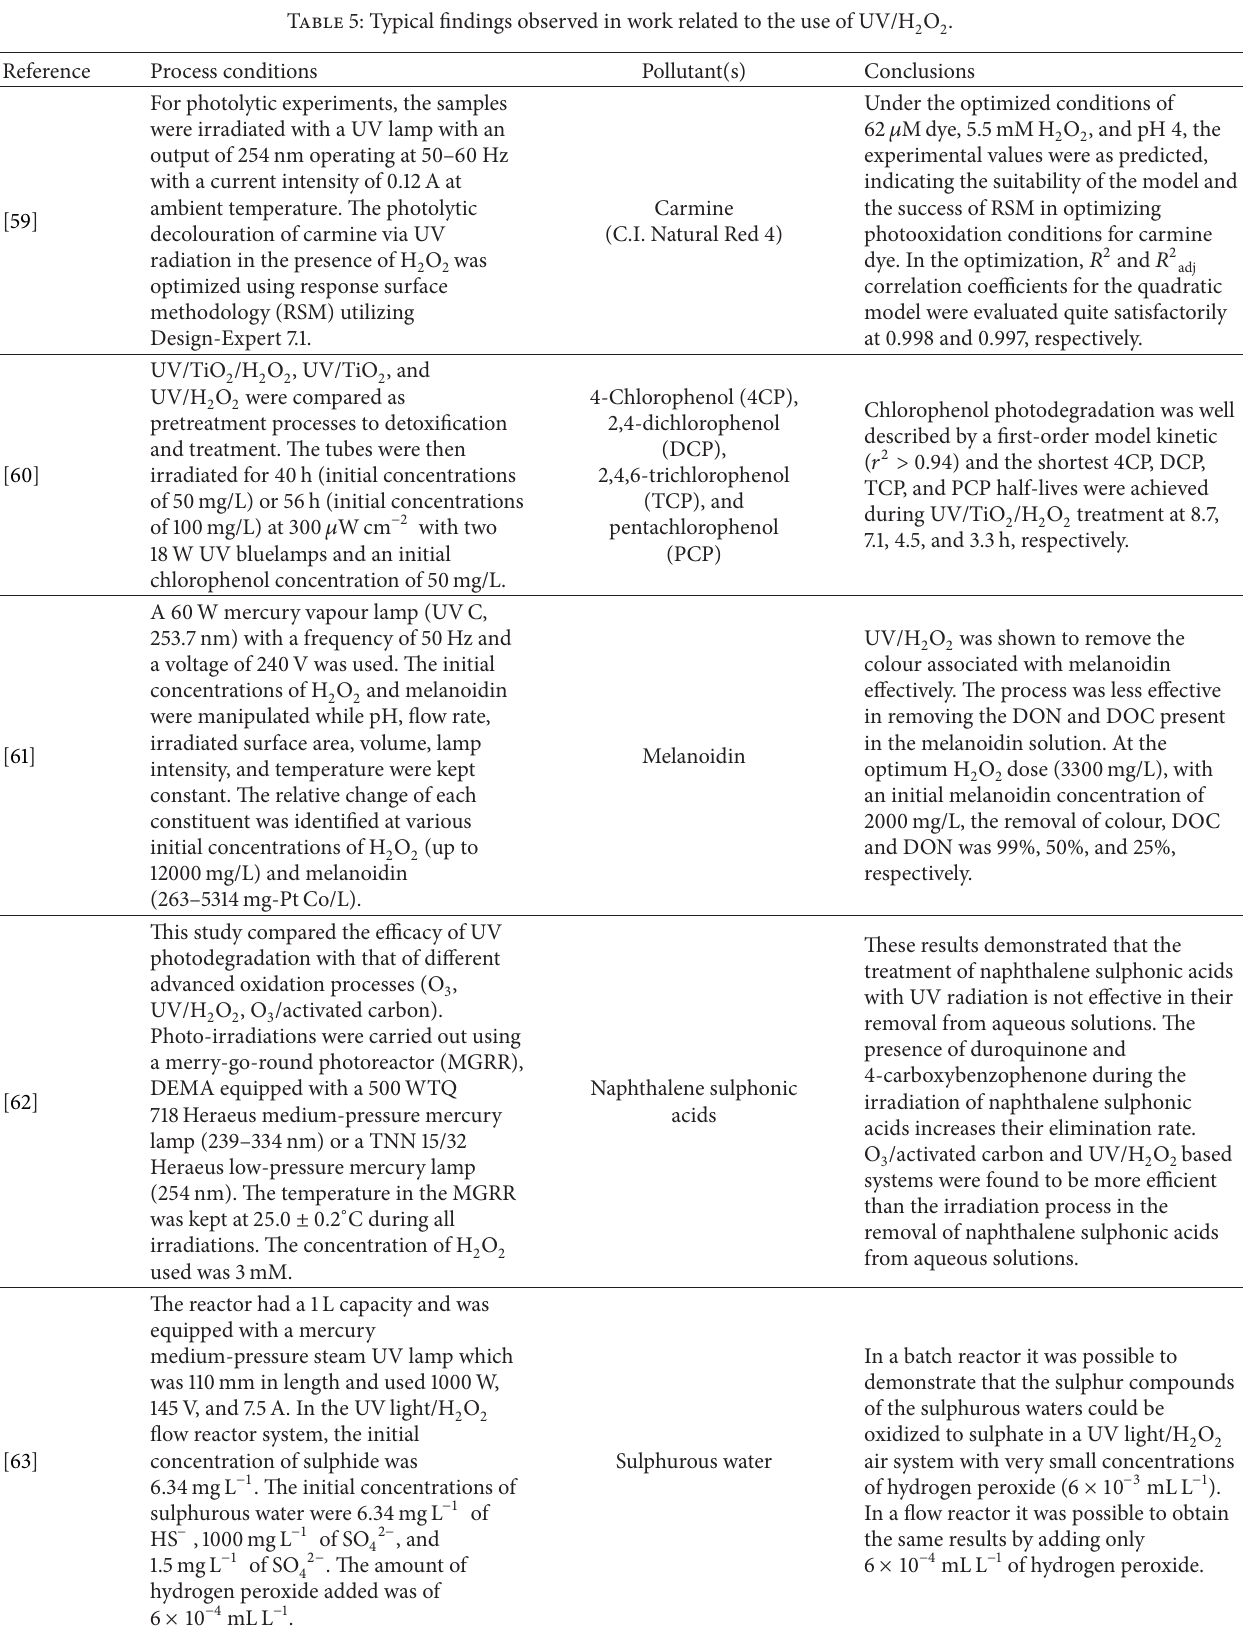
Table 5: Typical findings observed in work related to the use of UV/H